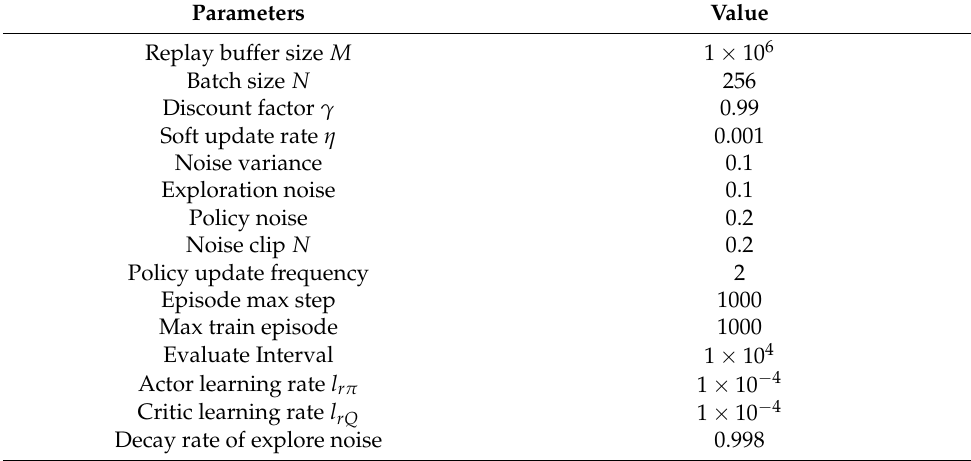
Table 2. Parameters of